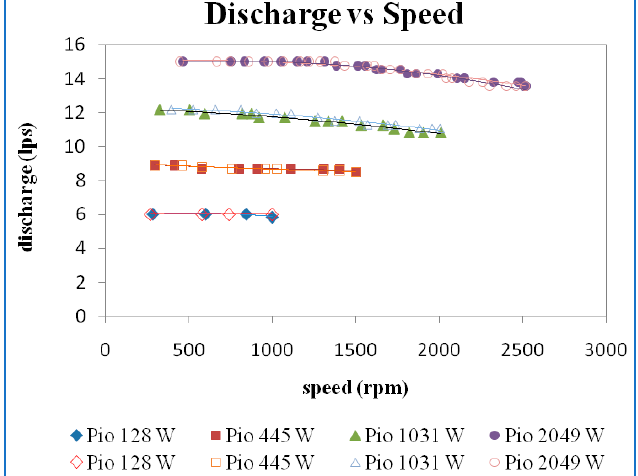
Figure 4. Discharge vs. speed at a guide vane opening of 10 mm.